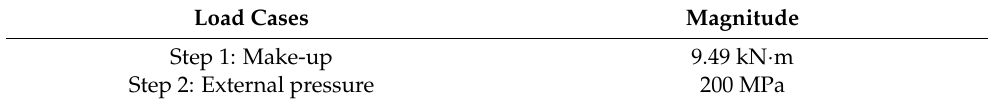
Figure 4. The section diagram of connection. In order to reveal the influence of wear depth on the collapse strength of the casing connection, the von Mises stress curve at a node where the stress is relatively concentrated on the engagement area of thread teeth (corresponding to the red symbol of zone I in Figure 4) was plotted with the change of external pressure during the increase of wear depth, as shown in Figure 5. For simplicity, it is referred to as node A1 below. Figure 5. Curve of stress variation with load at node A1.